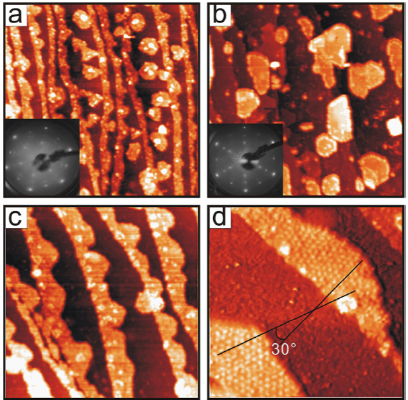
Figure 1. STM images of 0.6 ML cerium oxide film deposited on Ru(0001) at 700 K ( a ) and 790 K ( c ) in 1 × 10 − 7 mbar of O 2 ; ( b ) shows sample ( a ) further annealed in 4 × 10 − 7 mbar O 2 at 900 K. Image ( d ) is a close-up of the image ( c ), where two domains exhibiting the moiré structure with a 19 Å periodicity are rotated by 30 ˝ with respect to each other. Insets in ( a ) and ( b ) show the corresponding LEED patterns. Image size is 200 × 200 nm 2 ( a )–( c ) and 60 × 60 nm 2 ( d ). Reprinted with permission from Lu et al. [18]. Copyright Elsevier 2006.